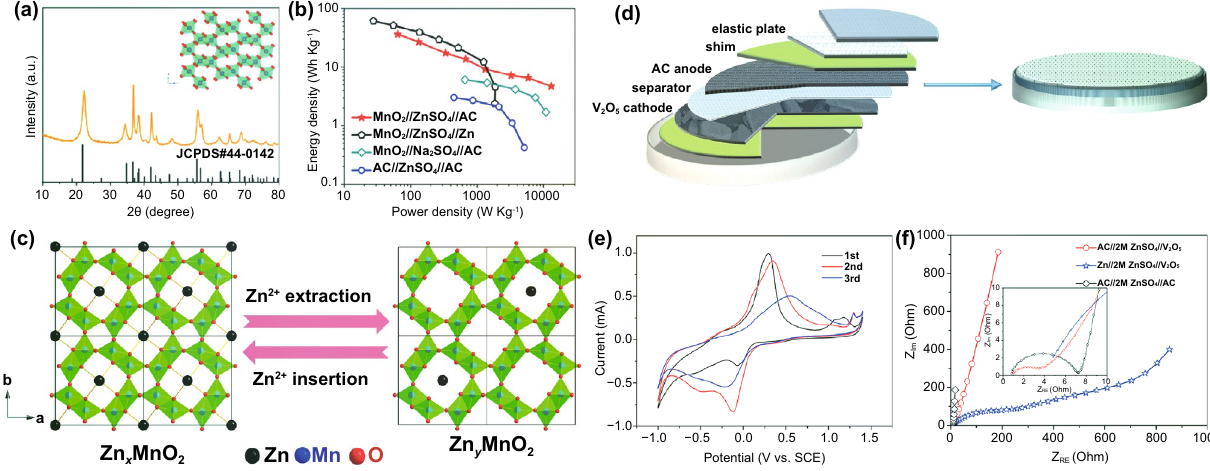
Fig. 8 a XRD pattern and crystal structure (inset) of γ ‑MnO 2 cathodes. b Ragone plots of various γ ‑MnO 2 ‑based ESSs. Reproduced with per‑ mission from Ref. [188]. Copyright 2019, Elsevier. c Schematic illustration of the Zn‑ion storage mechanisms in the tunnel‑structure Zn x MnO 2 cathode. Reproduced with permission from Ref. [34]. Copyright 2020, Wiley–VCH. d Full cell schematic of AC//2.0 M ZnSO 4 //V 2 O 5 ZHSCs. e CV curves tested by three‑electrode system of V 2 O 5 . f Nyquist plots of relevant devices, including ZHSC, ZIB and supercapacitor. Reproduced with permission from Ref. [189]. Copyright 2019, Springer